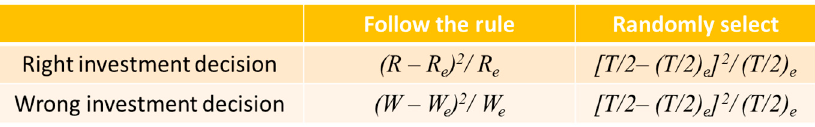
Figure 5. Chi-square level: χ 2 = ( f o − f e ) 2 f .